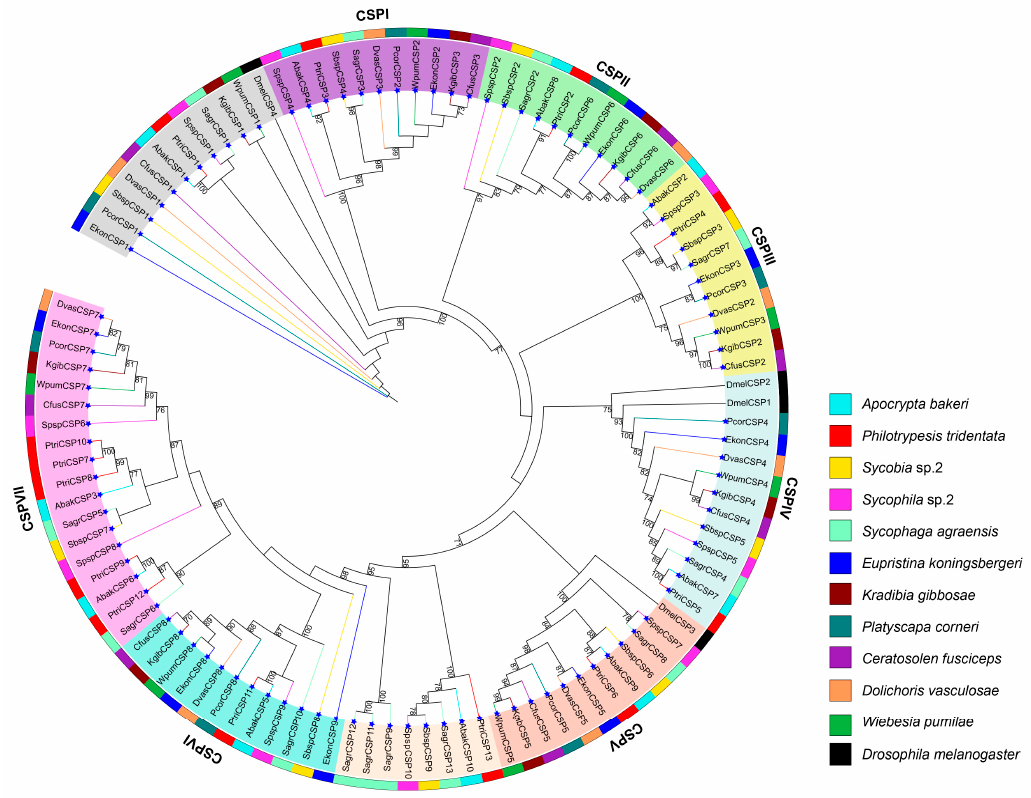
Figure 1. Phylogenetic tree of CSP genes from the 11 fig wasps and D. melanogaster . The phylogenetic tree was constructed by using the Maximum Likelihood (ML) method with 1000 bootstrap replications. Bootstrap values ≥ 70% are shown at the nodes. The CSP genes of D. melanogaster are abbreviated to DmelCSPs. The outermost colored rings represent the CSP genes of different species. The seven CSP groups are distinguished by different background colors. The blue star signs which are at the end of node branch represent the 104 CSP genes of the 11 fig wasps.